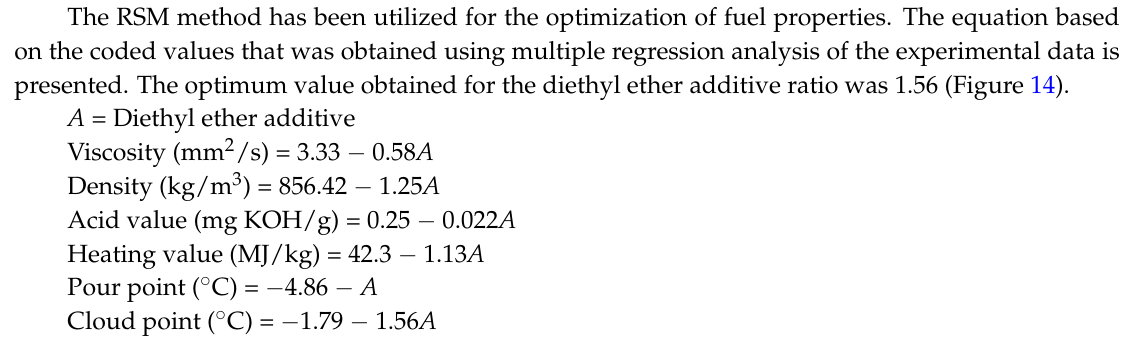
Figure 13. The interactive effect biodiesel and engine speed on the BTE. ( a ) 2D contour plots; and ( b ) 3D response surface plot.